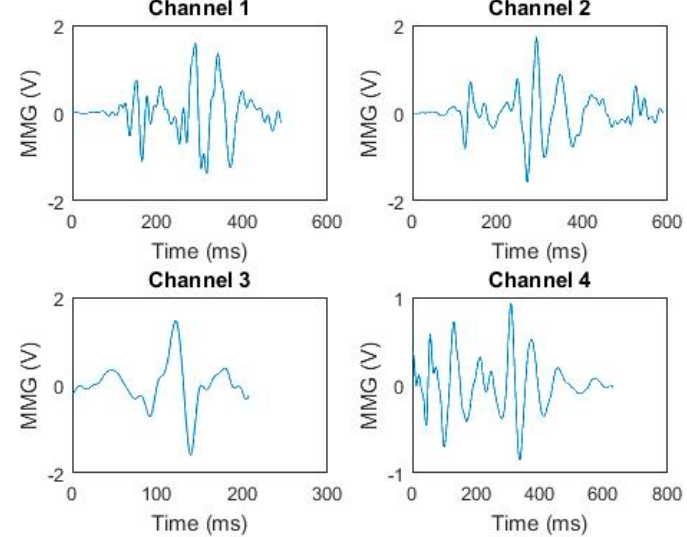
Figure 2. A typical segmentation of 4-channel pre-processed MMG signals.